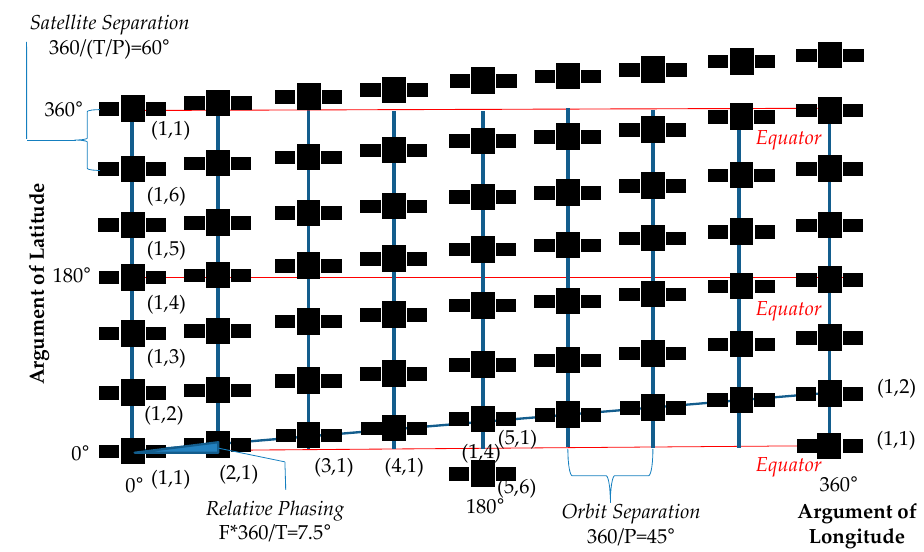
Figure 3. Walker pattern of Globalstar satellite constellation.